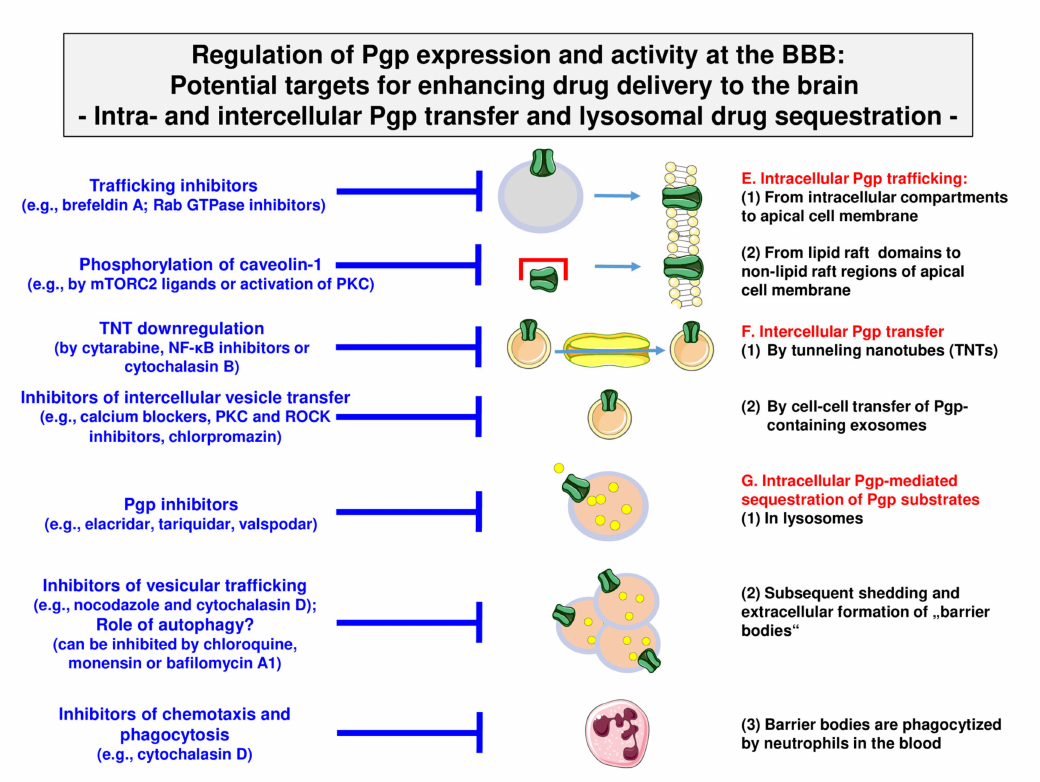
Figure 7. Pharmacological inhibition of the processes involved in intra- and intercellular Pgp tra ffi cking and Pgp-mediated lysosomal drug sequestration. Note that the di ff erent cell and vesicle types are not drawn to scale. See Figure 3 and text for